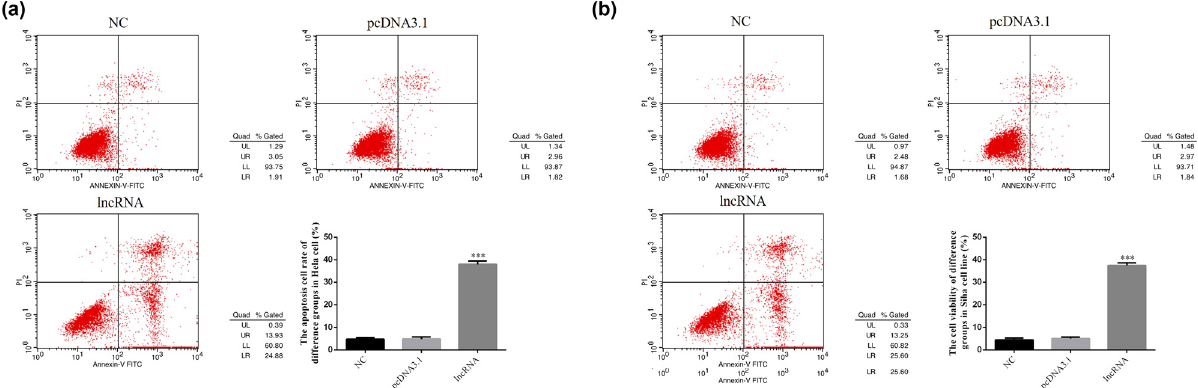
Figure 3: The cell apoptosis rate of di ff erence groups by fl ow cytometry in HeLa and SiHa cell lines. NC: normal control group; pcDNA 3.1: the cells were transfected with pcDNA3.1; lncRNA: the cells were transfected with UBE2R2 - AS1 by pcDNA3.1. ( a ) The cell apoptosis rate of di ff erence groups by fl ow cytometry in HeLa cell. *** P < 0.001, compared with NC group. ( b ) The cell apoptosis rate of di ff erence groups by fl ow cytometry in SiHa cell. *** P < 0.001, compared with NC group.